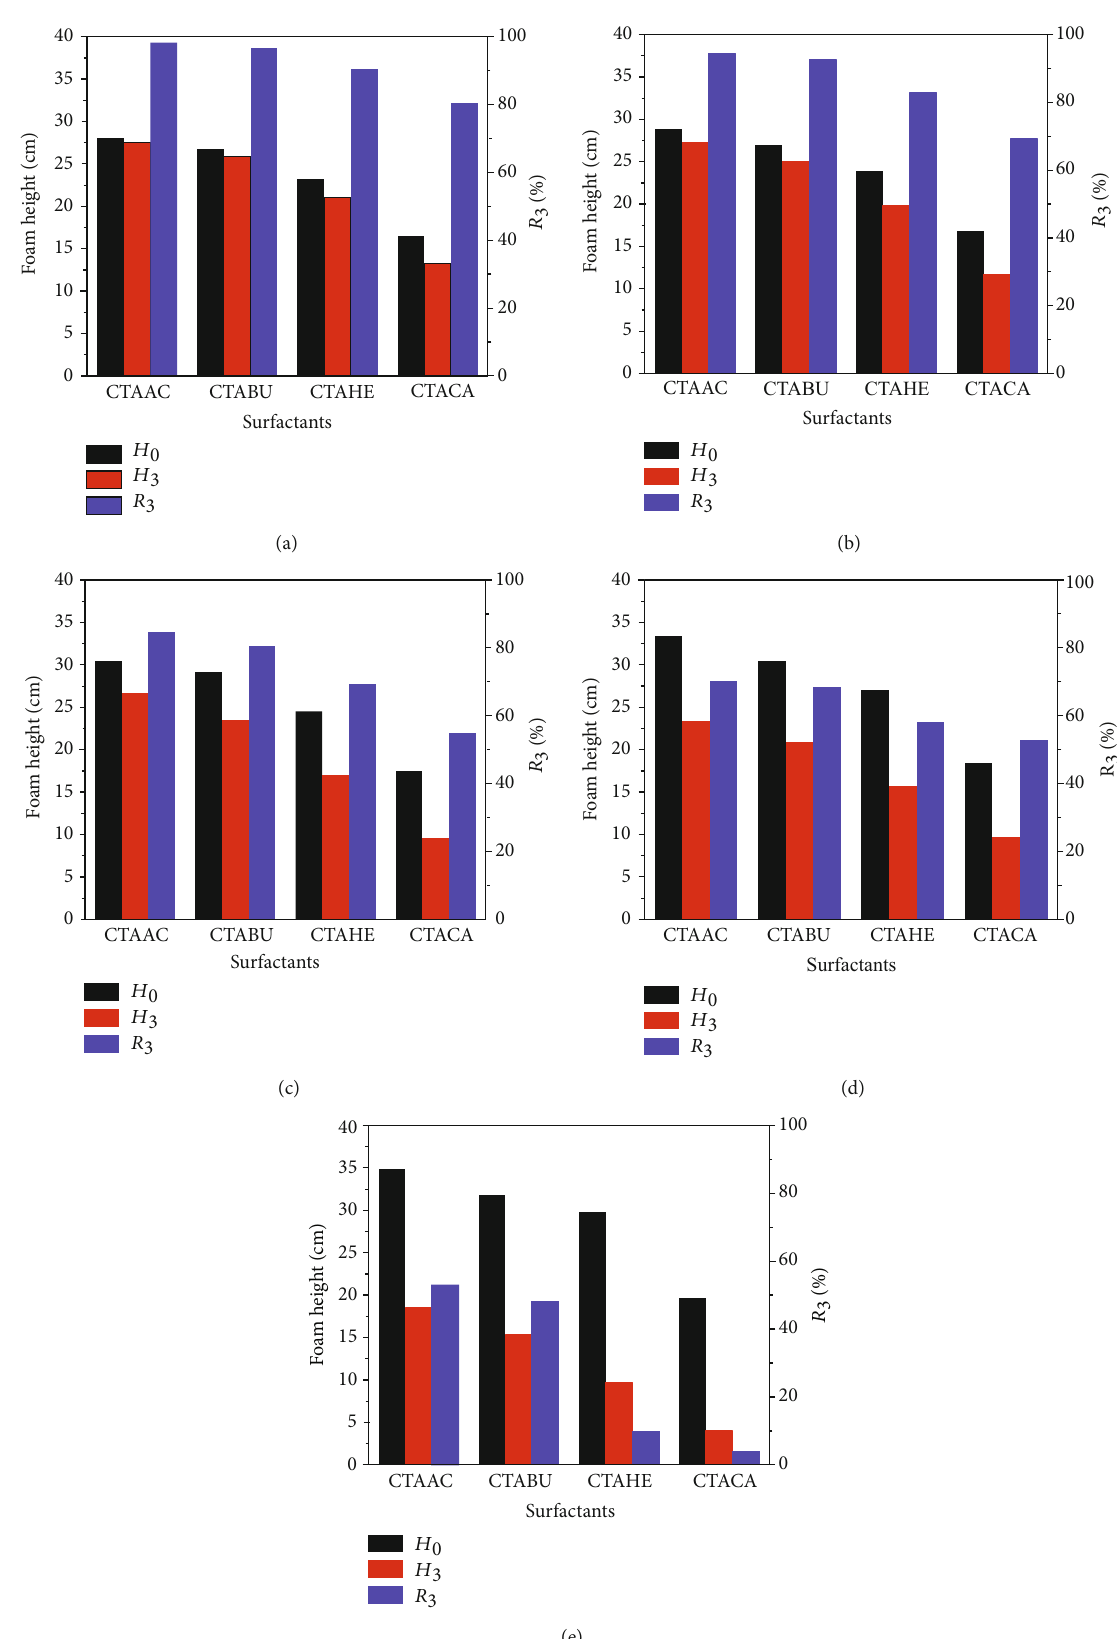
Figure 4: Changeoffoamheightand R withdi ff erenttemperaturesovervarioussurfactants:(a)30 ° C,(b)40 ° C,(c)50 ° C,(d)60 ° C,and(e)70 ° 3